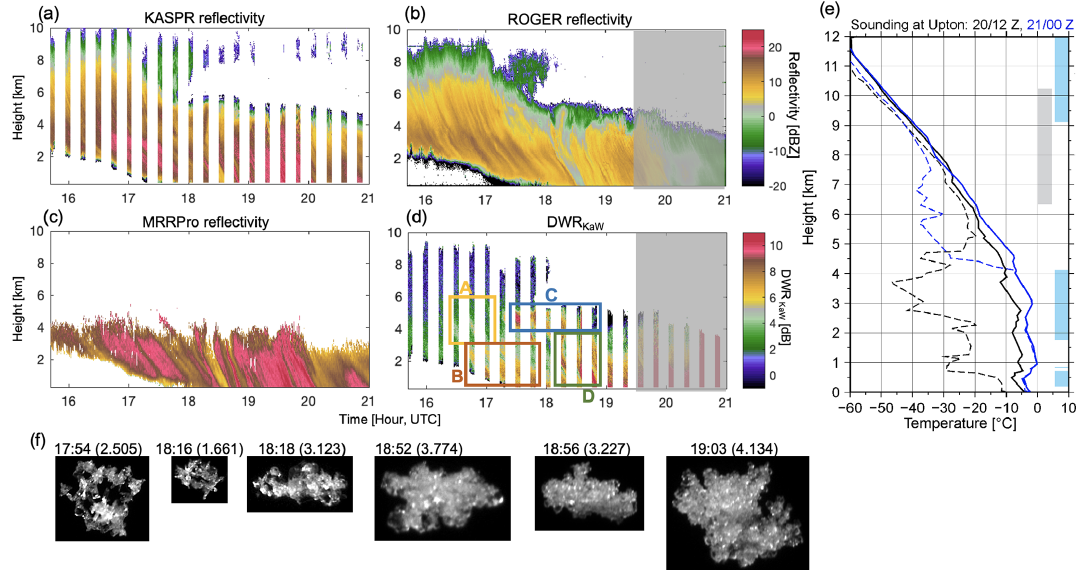
Figure 4. Height–time cross sections of (a) KASPR VPT reflectivity, (b) ROGER reflectivity, (c) MRRPro reflectivity, and (d) DWR of KASPR reflectivity to ROGER reflectivity on 20 February 2019; (e) vertical profiles of temperature (solid line) and dew point temperature (dashed line) from the NWS Upton sounding measurements at 12:00UTC on 20 February (black color) and 00:00UTC on 21 February (blue color) 2019; and (f) examples of snowflake images captured by the MASC. Boxes in (d) represent analysis regions used for Figs. 7–10. Gray and blue shades in (e) represent regions of supersaturation with respect to ice for 12:00UTC on 20 February and 00:00UTC on 21 February, respectively. Each image in (f) displays observation time and maximum dimension in parentheses (unit is